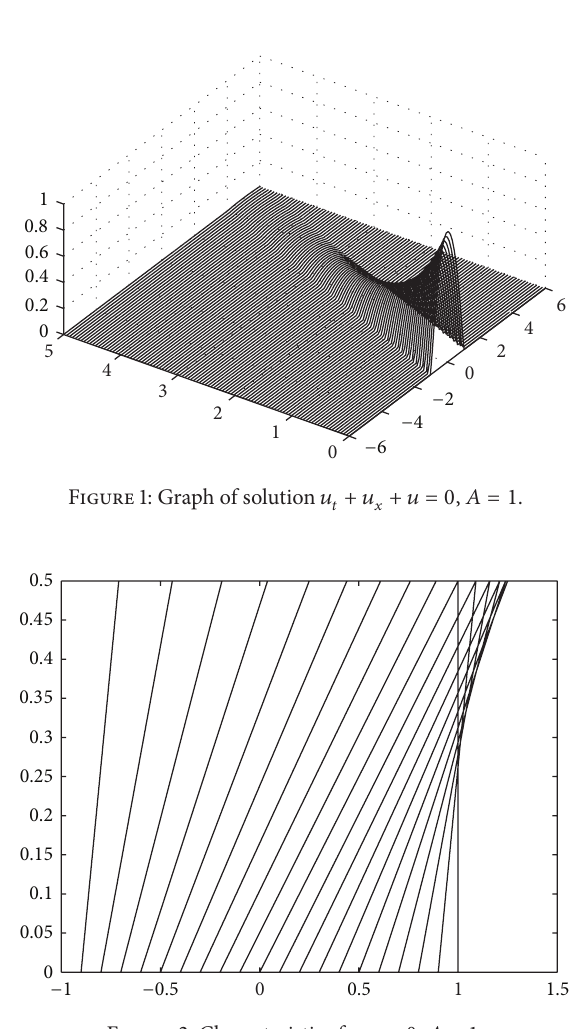
Figure 2: Characteristics for 𝑢 = 0 , 𝐴 = 1 .